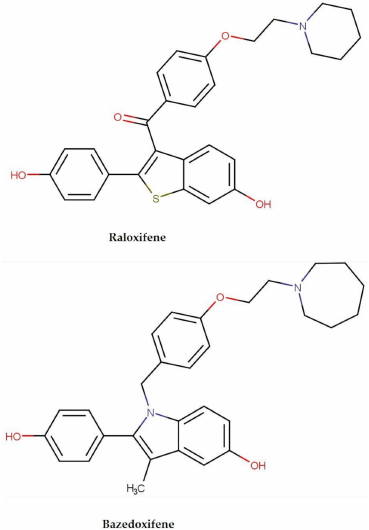
Figure 3. Chemical structures of SERMs discussed in the review. Both raloxifene and bazedoxifene belong to the II class of BCS—as lipophilic com- pounds they are hardly soluble in water and easily permeable by membrane cells.